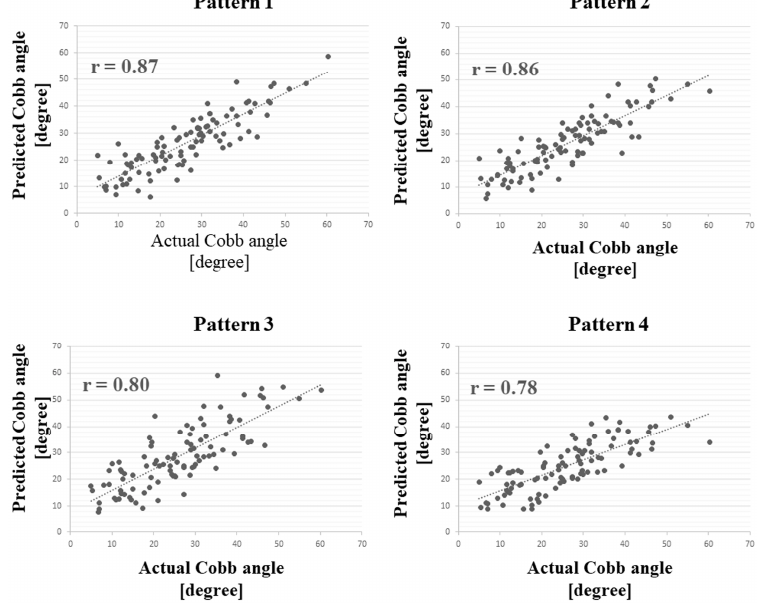
Figure 4. Correlation in the total number of subjects between the actual Cobb angle and the predicted Cobb angle.